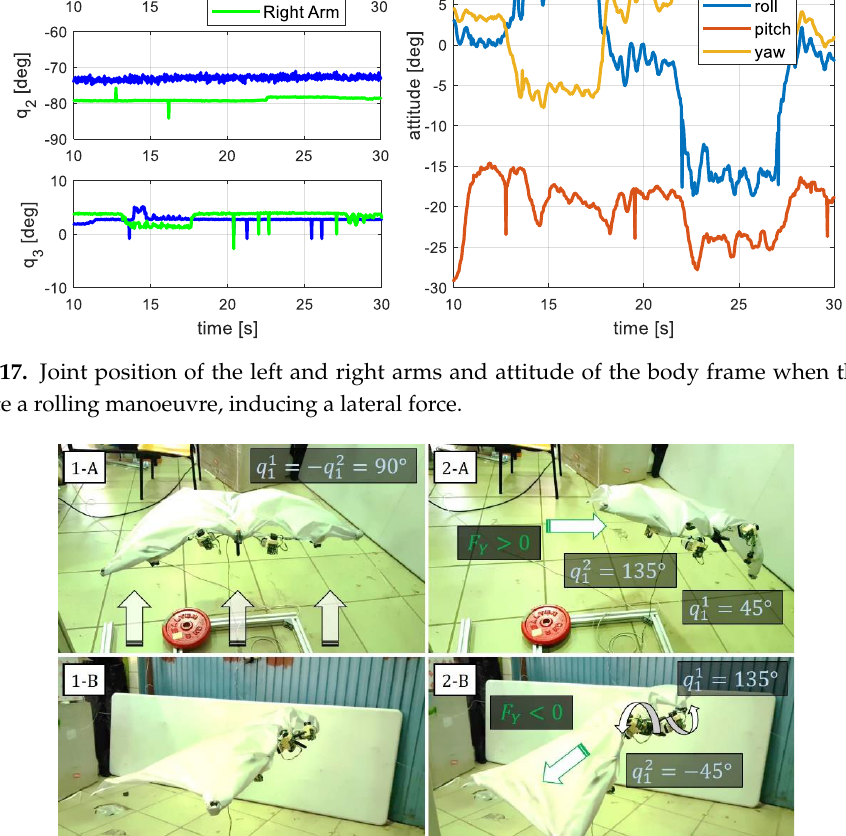
Figure 19. Wind tests conducted outdoors for evaluating the tail pitching ( A ) and shoulder rolling ( B ) effects.